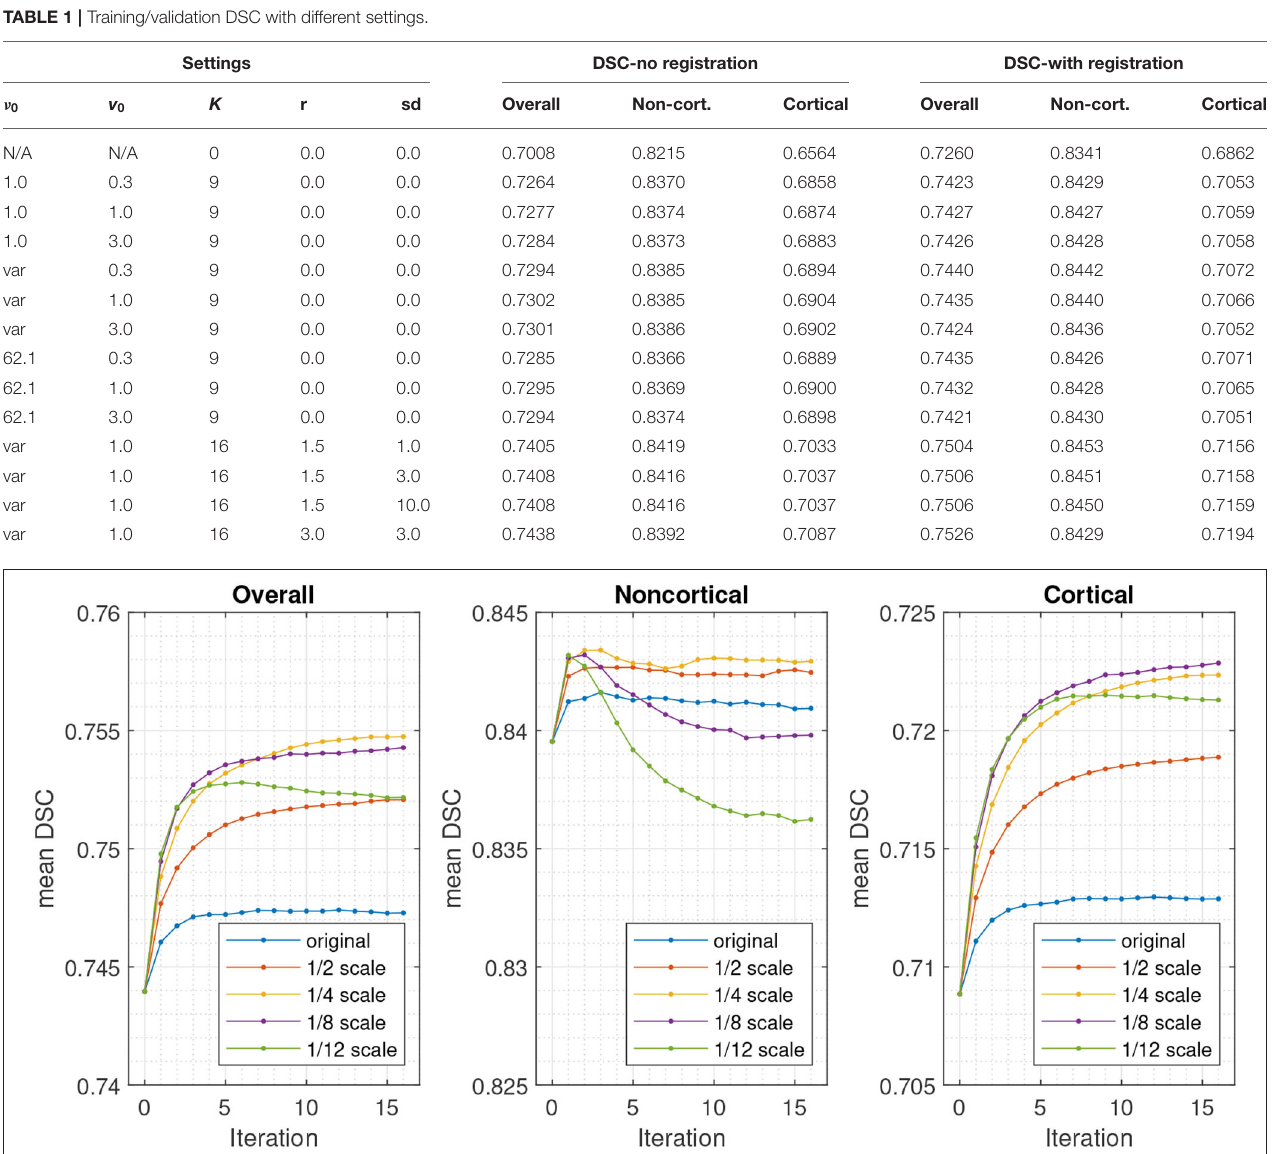
FIGURE 7 | DSC for validation set using different numbers of registration iterations and degrees of regularisation, relative to that used for the initial registration and segmentation.